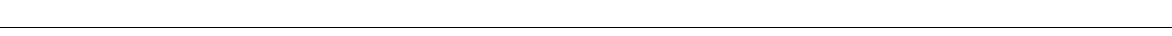
Fig. 8 Mechanosensory-like taste neurons of the geniculate ganglion. a . PCA from Fig. 2b, re-colored as assigned in Fig. 4a to display taste sub-clusters, T1, T2, T3, and somatosensory cluster. Neurons of sub-cluster T2 (orange) appear midway between other taste neurons and the somatosensory (black) neurons of the ganglion. b . Expression in all 96 neurons of 4 genes ( Calb1, Hs3sT2, Runx3 and Gfra2 ) that are selectively expressed in T2 neurons, and 2 genes ( Pcdh7, Cadps2 ) that are shared between T2 neurons and somatosensory neurons of the ganglion. Cluster and sub-cluster assignments are indicated below the bar graphs. c . In spite of expressing some somatosensory genes, T2 neurons are bona fi de taste neurons as shown by the presence of anterograde labeling dye in the cytoplasm surrounding each Mafb+ nucleus (25 of 27 Mafb+ nuclei counted in 9 sections from 4 mice; fi lled arrowhead). d . Neurons of sub-cluster T2 (i.e. Mafb+, fi lled arrowhead) selectively express calbindin 1; few other neurons in the ganglion express this cytosolic